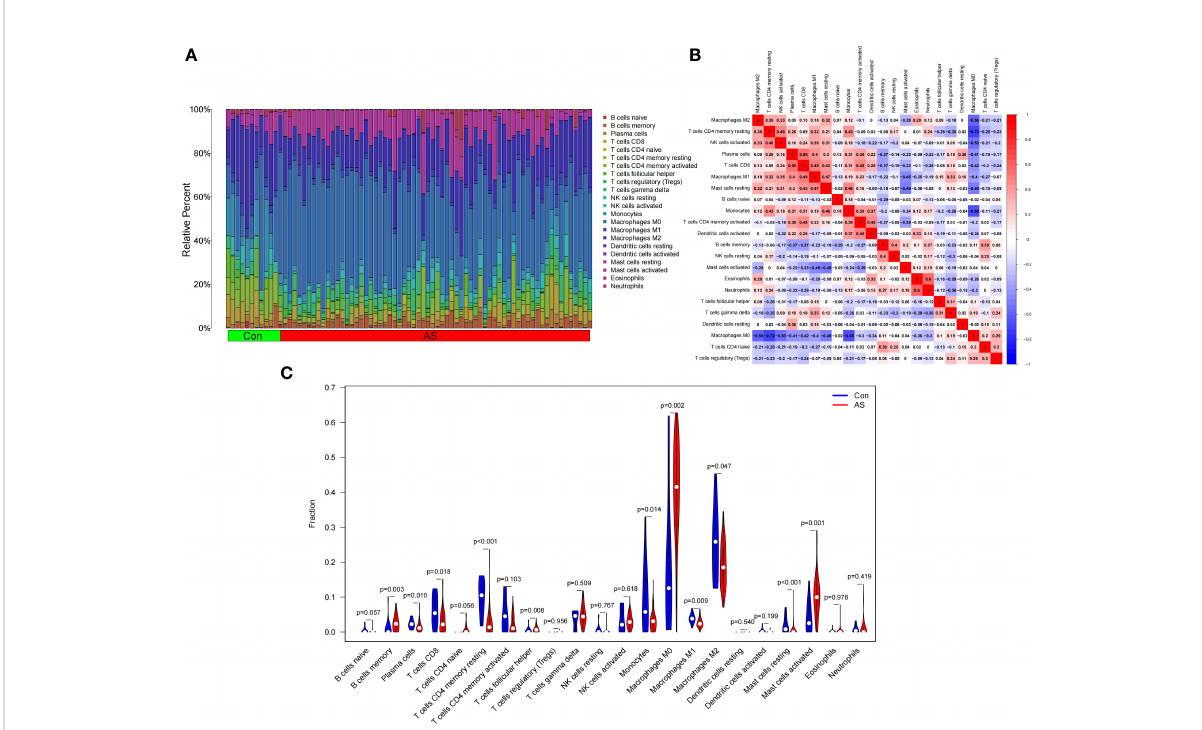
FIGURE 9 Landscape map of in fi ltrating immune cells (IICs) in the atherosclerosis (AS) and control (Con) groups. (A) The relative proportion of IICs in AS and Con. (B) Correlation heatmap between IICs. Red represents positive correlation, blue represents negative correlation, and the number in the square represents correlation. (C) Violin diagram showing the difference in immune cell in fi ltration between AS and Con. (AS group shown in red, Con group shown in blue, p < 0.05 was considered statistically signi fi cant).